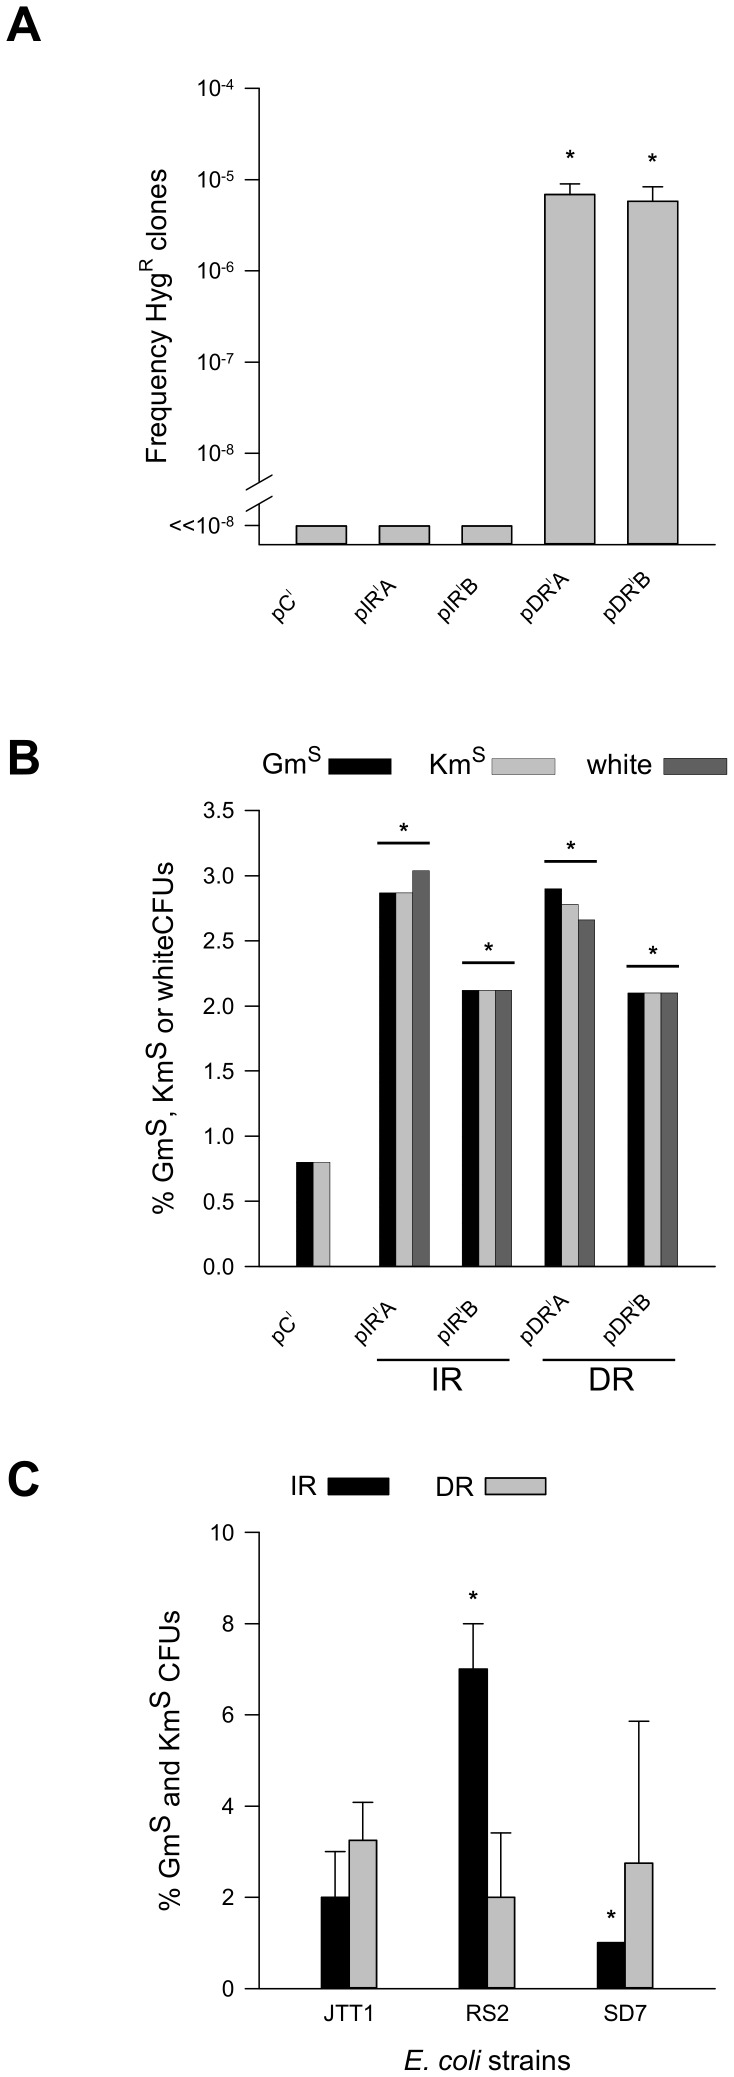
OligoDR and OligoIR induce genetic instabilities in M. smegmatis and E. coli.
Panel A, reconstitution of hph (HygR) gene through the precise deletion of the aacC1 (GmR) is only detected with the integrated OligoDR, but not OligoIR, in M. smegmatis. x-axis, M. smegmatis mc2155 strains: pCI, pMV306KmHyg::Gm (control); pIRIA, pMV306KmHyg::OligoIRGmA
lacZ; pIRIB, pMV306KmHyg::OligoIRGmB
lacZ; pDRIA, pMV306KmHyg::OligoDRGmA
lacZ; pDRIB, pMV306KmHyg::OligoDRGmB
lacZ; y-axis, frequencies of HygR CFUs: asterisks, p<0.05 (pair-wise Holm-Sidak test for pIRIA, pIRIB, pDRIA, pDRIB against pCI). Panel B, large deletions occur in both the integrated OligoDR and OligoIR constructs in M. smegmatis. x-axis, as in Panel A; y-axis, percent GmS (black bars), KmS (light grey bars), and white (dark grey bars) CFUs; IR, OligoIR; DR, OligoDR.; asterisks, p<0.05 (χ2 test of pIRIA, pIRIB, pDRIA, pDRIB against pCI, z-test of pIRIA against pIRIB and pDRIA against pDRIB). Panel C, OligoIR induces deletions in a supercoiling-dependent manner in E. coli. Percent GmS and KmS CFUs in E. coli strains containing various steady-state levels of negative supercoil density. x-axis, E. coli strains carrying the self-replicating OligoIR (pIREA) or OligoDR (pDREA) vectors: JTT1, wild-type; RS2, topA mutant, higher negative supercoil density than JTT1; SD2, topA and gyrB mutant, lower negative supercoil density than JTT1; y-axis, percent GmS and KmS CFUs, geometric mean (+/−SD) from 100 CFUs obtained from 3 independent experiments; black bars, OligoIR (pIREA); grey bars, OligoDR (pDREA); asterisks, p<0.05 (χ2 test of SD7 against RS2 and RS2 against JTT1).